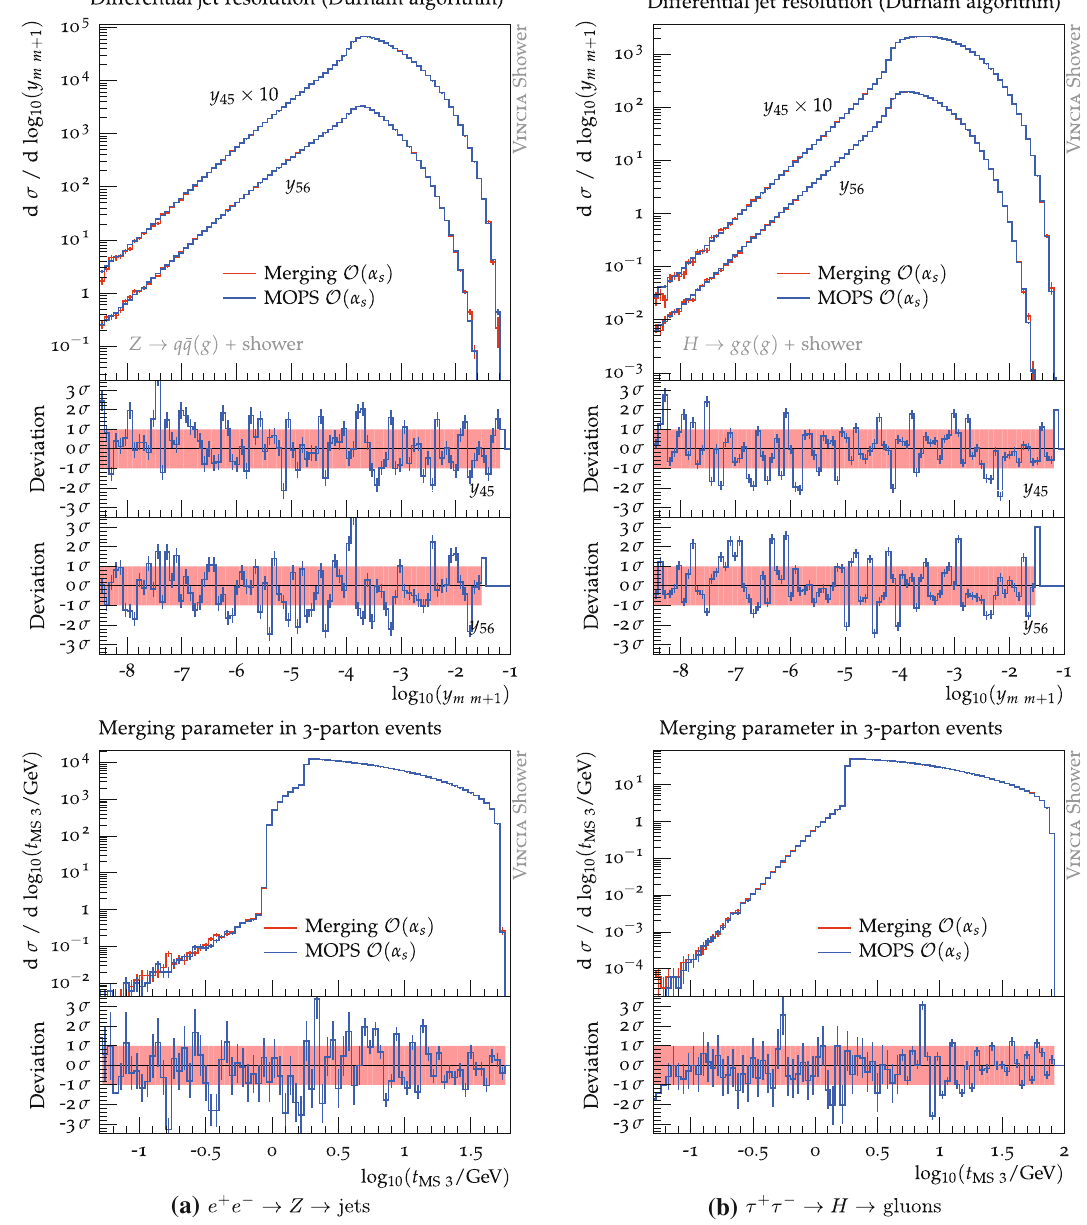
Fig. 6 Parton-levelresults:thedistributionofthemergingscaleinexclusive3-partonevents( bottom )andthelogarithmicdistributionsofdifferential jet resolutions ( top ). Merged predictions with a merging-scale value of 5 GeV are compared to predictions with the MOPS